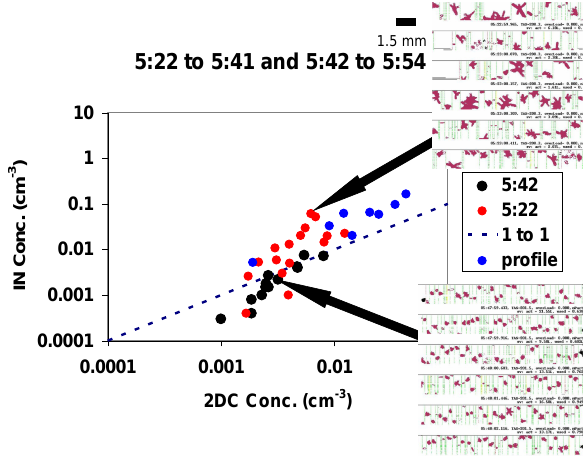
Fig. 8. Ice Nuclei and 2DC concentrations for the periods 05:22 to 05:41 (data from 05:33–05:35 are not available, red symbols), 05:42 to 05:54 (black symbols) and during the upper part (tempera- tures between − 22 and − 3 ◦ C) of the vertical profile in Fig. 7 (blue symbols). Data are 60 averages. 2DC images corresponding to the selected points (arrows) are